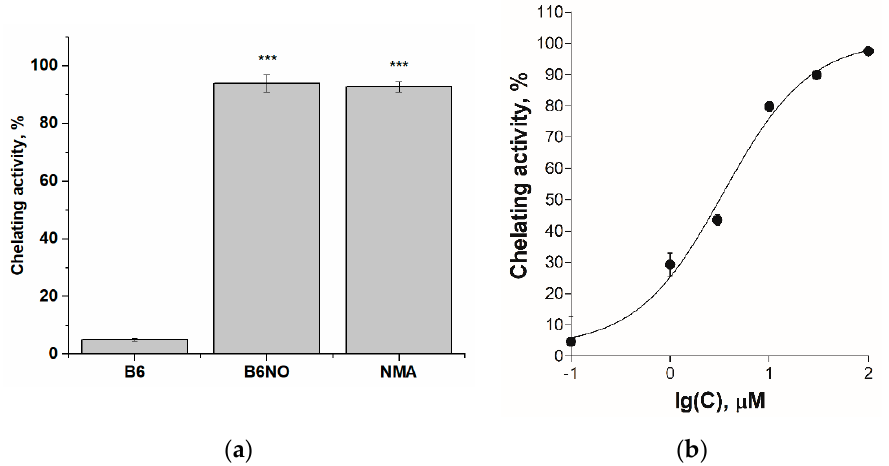
Figure 3. ( a ) Fe(II)-chelating activity of the B 6 , B6NO and nitromalic acid (NMA) at a concentration of 30 μ M. Significant differences are shown as *** p < 0.001.; ( b ) Concentration dependence of the increase in Fe(II)-chelating activity of the B6NO hybrid molecule.